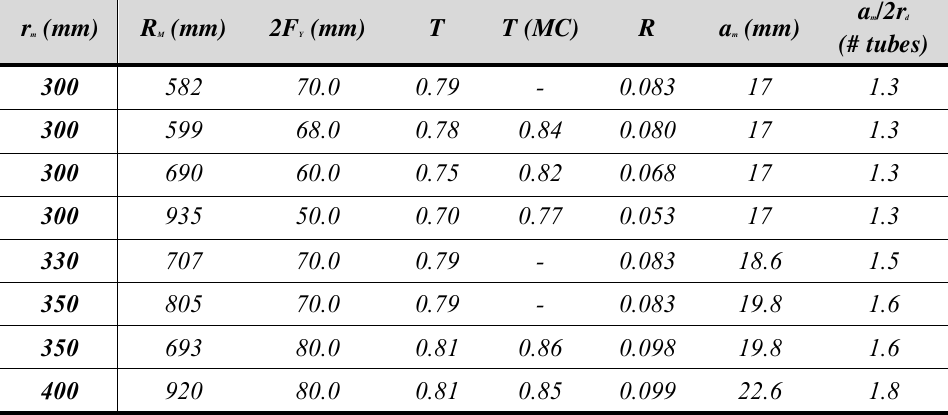
Table 1. A list of potential options for the MIRACLES radial collimator and estimated performance in terms of transmission (comparing analytical and Monte Carlo calculations), background reduction, and detector